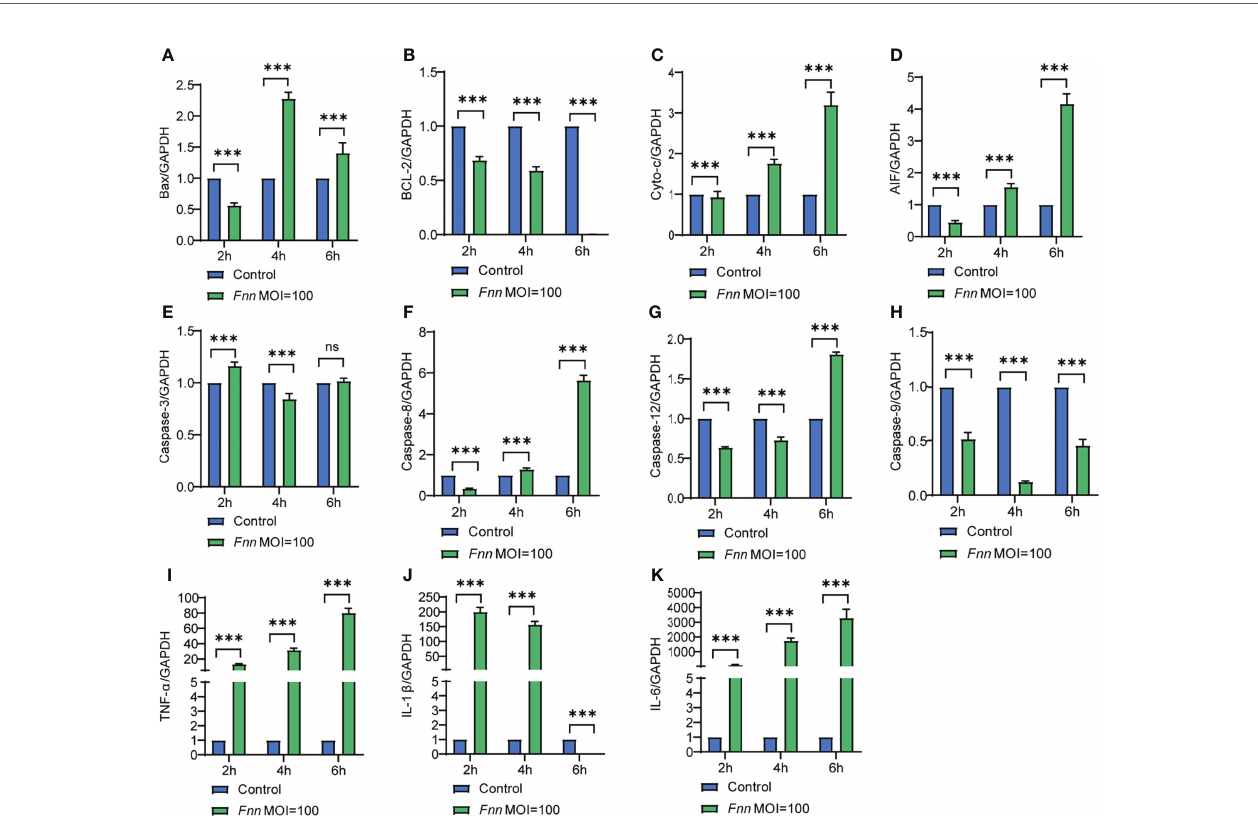
FIGURE 3 | The effect of F. necrophorum on apoptosis and in fl ammatory factors of macrophages was detected by RT-qPCR. Bax (A) , Bcl-2 (B) , cyto-c (C) , AIF (D) , caspase-3 (E) , caspase-8 (F) , caspase-12 (G) , caspase-9 (H) , TNF- a (I) , IL-1 b (J) and IL-6 (K) gene expression with F. necrophorum stimulation (MOIs of 0 and 100) from 0 to 6 h ( n = 3). *** P <0.001, ns, not signi fi